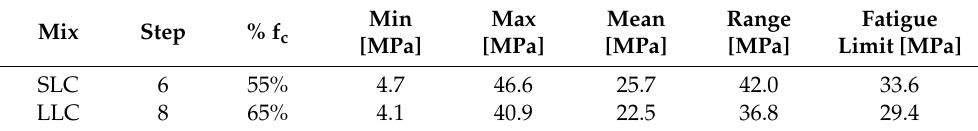
Table 7. Fatigue failure for mixes LLC and SLC: criterion of 80% of the stress range.